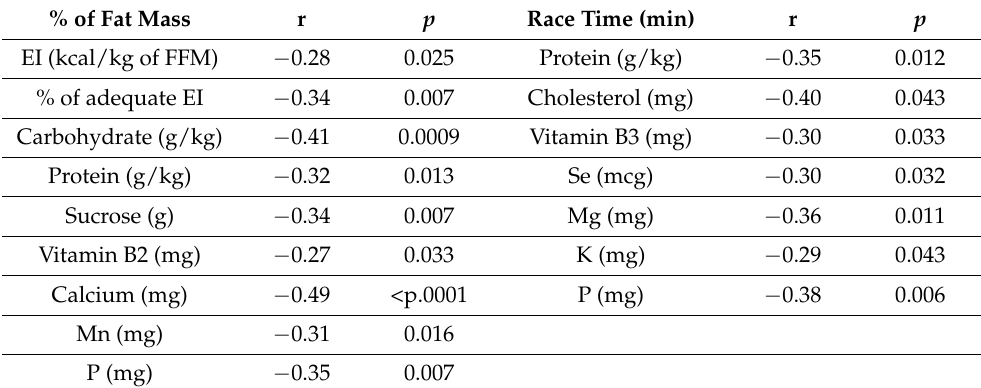
Table 4. Correlation of dietary intake with % of fat mass and race time.